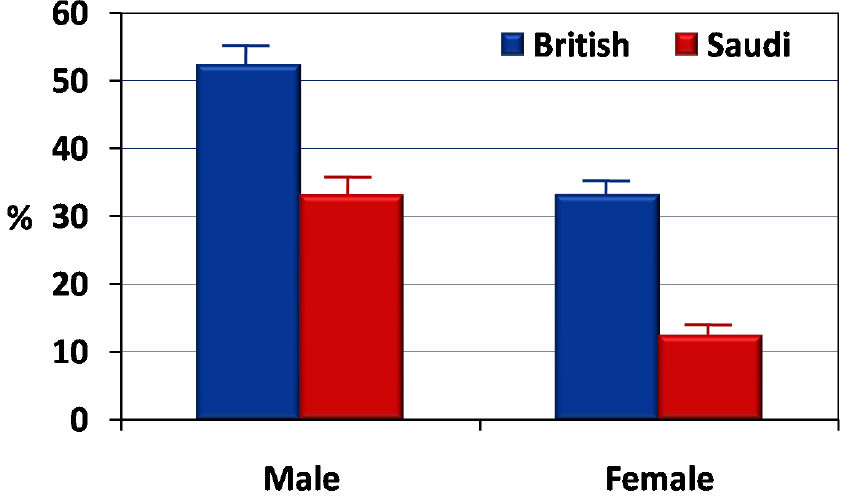
Figure 2. Ratios (%) of physical activity level (hours/day) to sedentary behaviors (screen time in